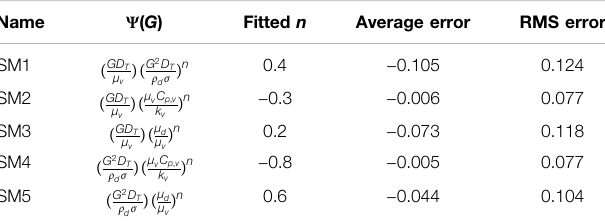
TABLE 3 | Results of the average and RMS errors of each form of the scaling methods with fi tted n